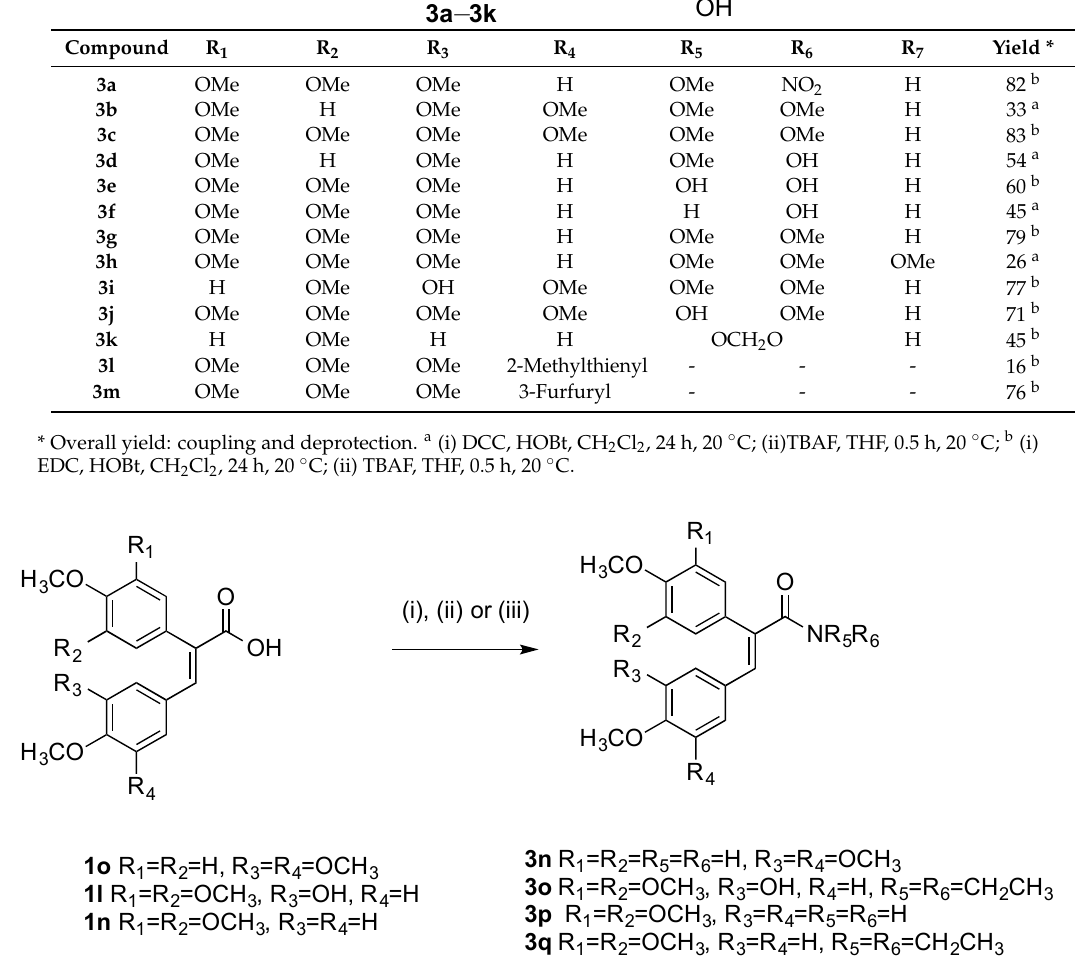
Scheme 3. Synthesis of combretastatin-amides 3n – 3q : Reagents and conditions : 3o , 3q ( i ) Mukaiyama’s